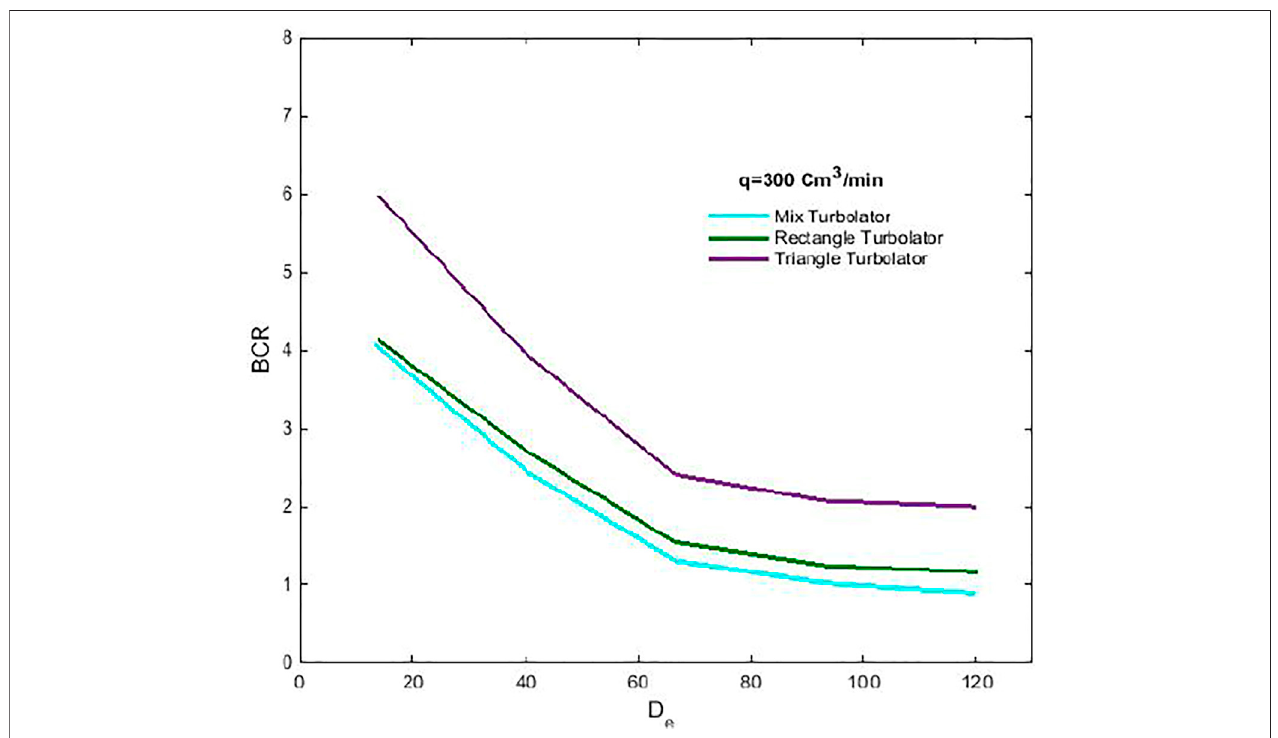
FIGURE 7 | Comparison of BCR factor for the represented